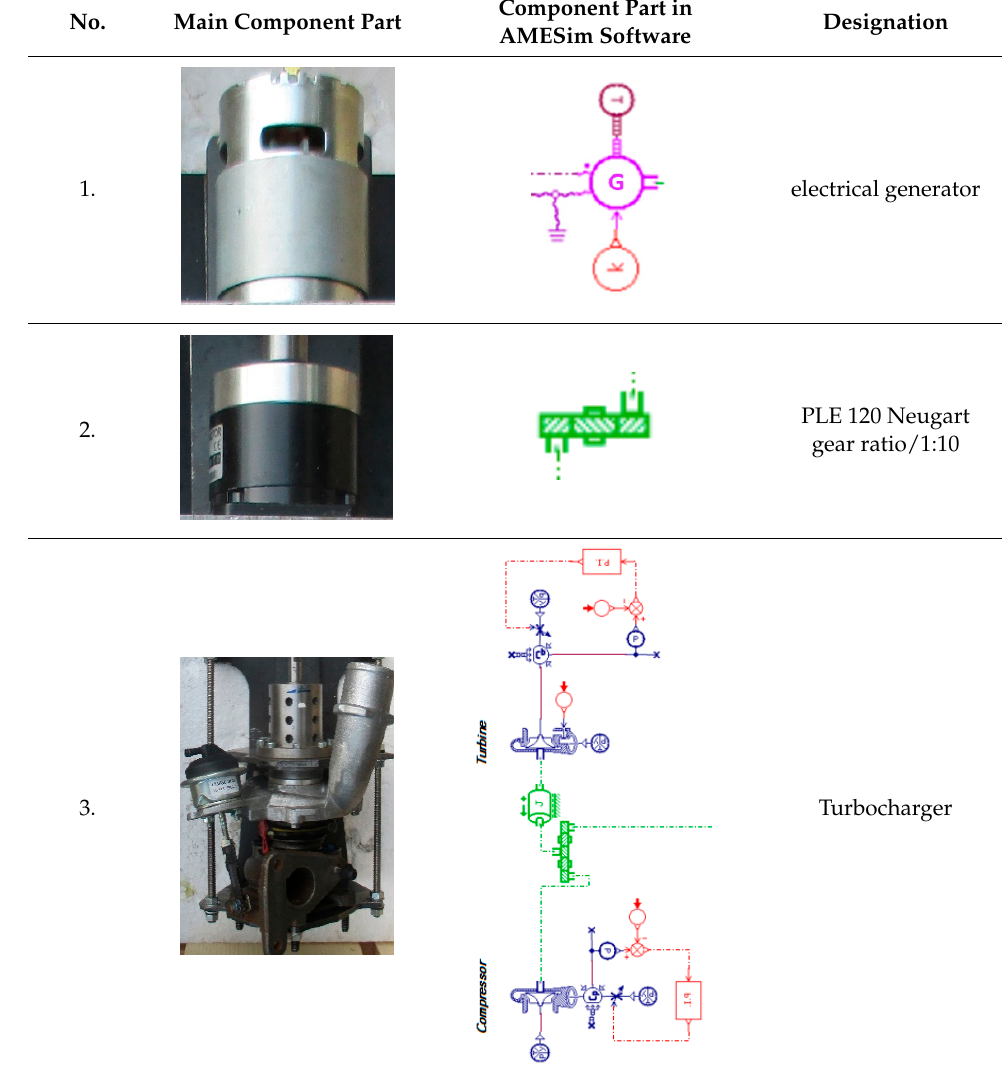
Table 1. Main component parts of the hybrid turbocharger.